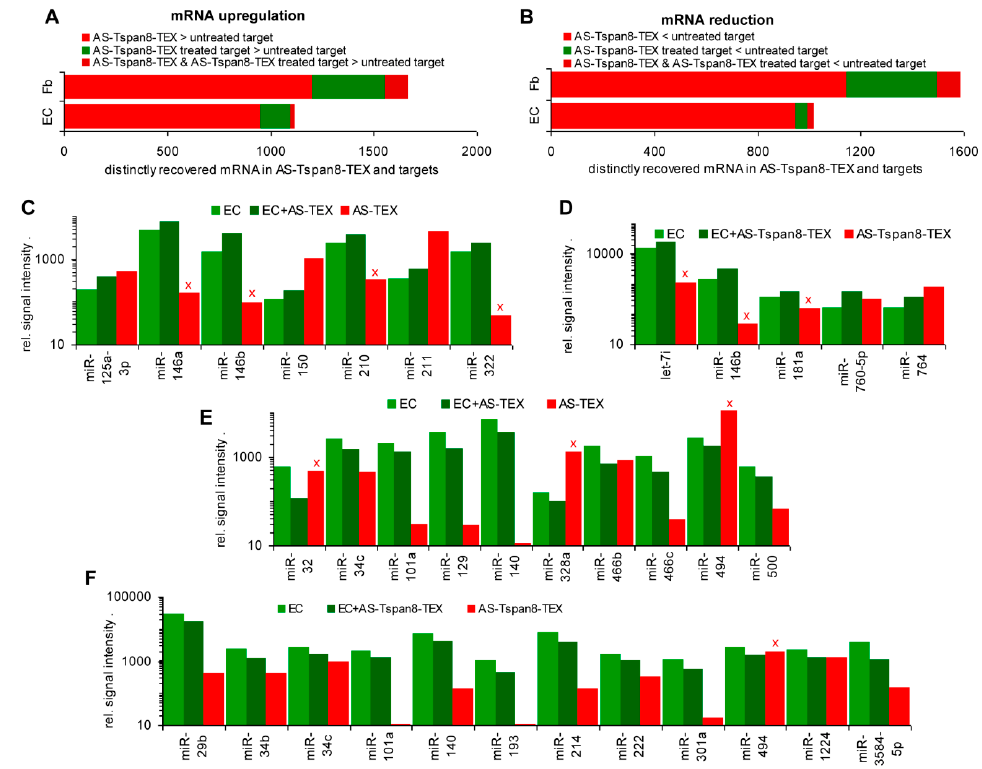
Figure 3. mRNA and miRNA in TEX, TEX-treated fibroblasts, and endothelial cells in comparison